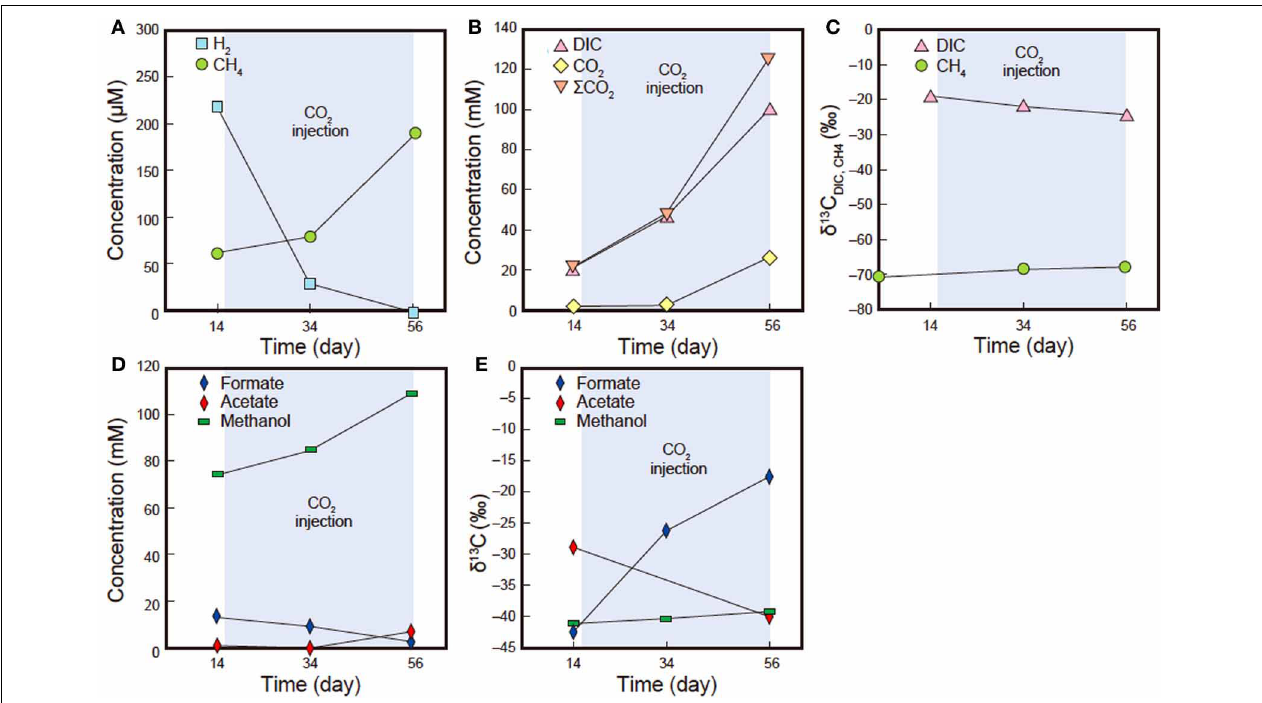
FIGURE 9 | H 2 , CH 4 , CO 2 , DIC, (cid:2) CO 2 , formate, acetate, methanol concentrations and carbon isotope compositions ( δ 13 C) of DIC and CH 4 insub-sampled fluids (samples Pre14d, Pre34d and Pre56d). (A) Dissolved H 2 and CH 4 concentrations. (B) Dissolved CO 2 , DIC and (cid:2) CO 2 concentrations. (C) δ 13 C DIC and δ 13 C CH4 . (D) Dissolved formate, acetate